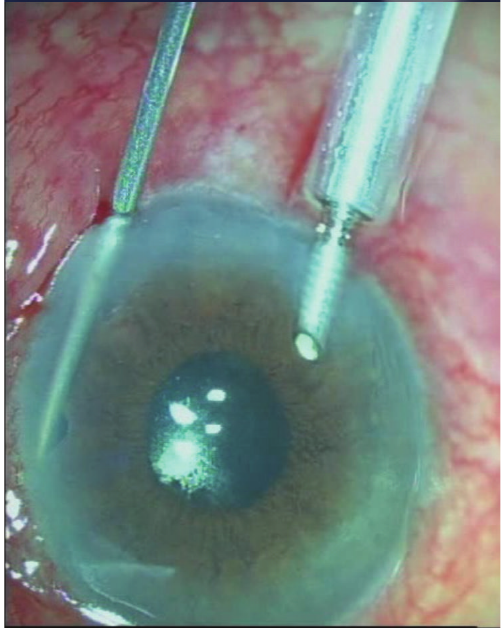
Figure 1: Peripheral iridectomy, capsulo-hyaloidectomy, and ante- rior vitrectomy procedure in malignant glaucoma.